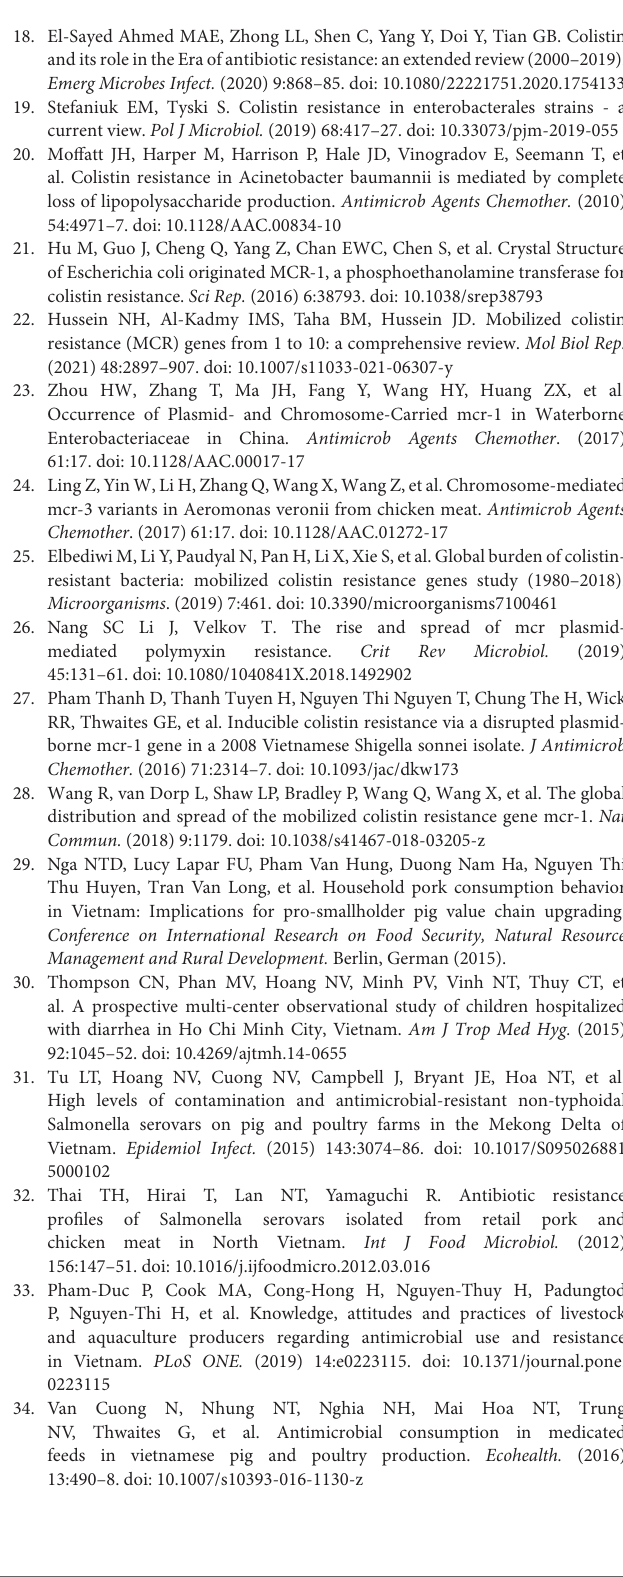
Supplementary Table 4 | Antibiotic resistance. Phenotypic antimicrobial resistance to six classes of antibiotics were tested using CLSI guidelines. Draft